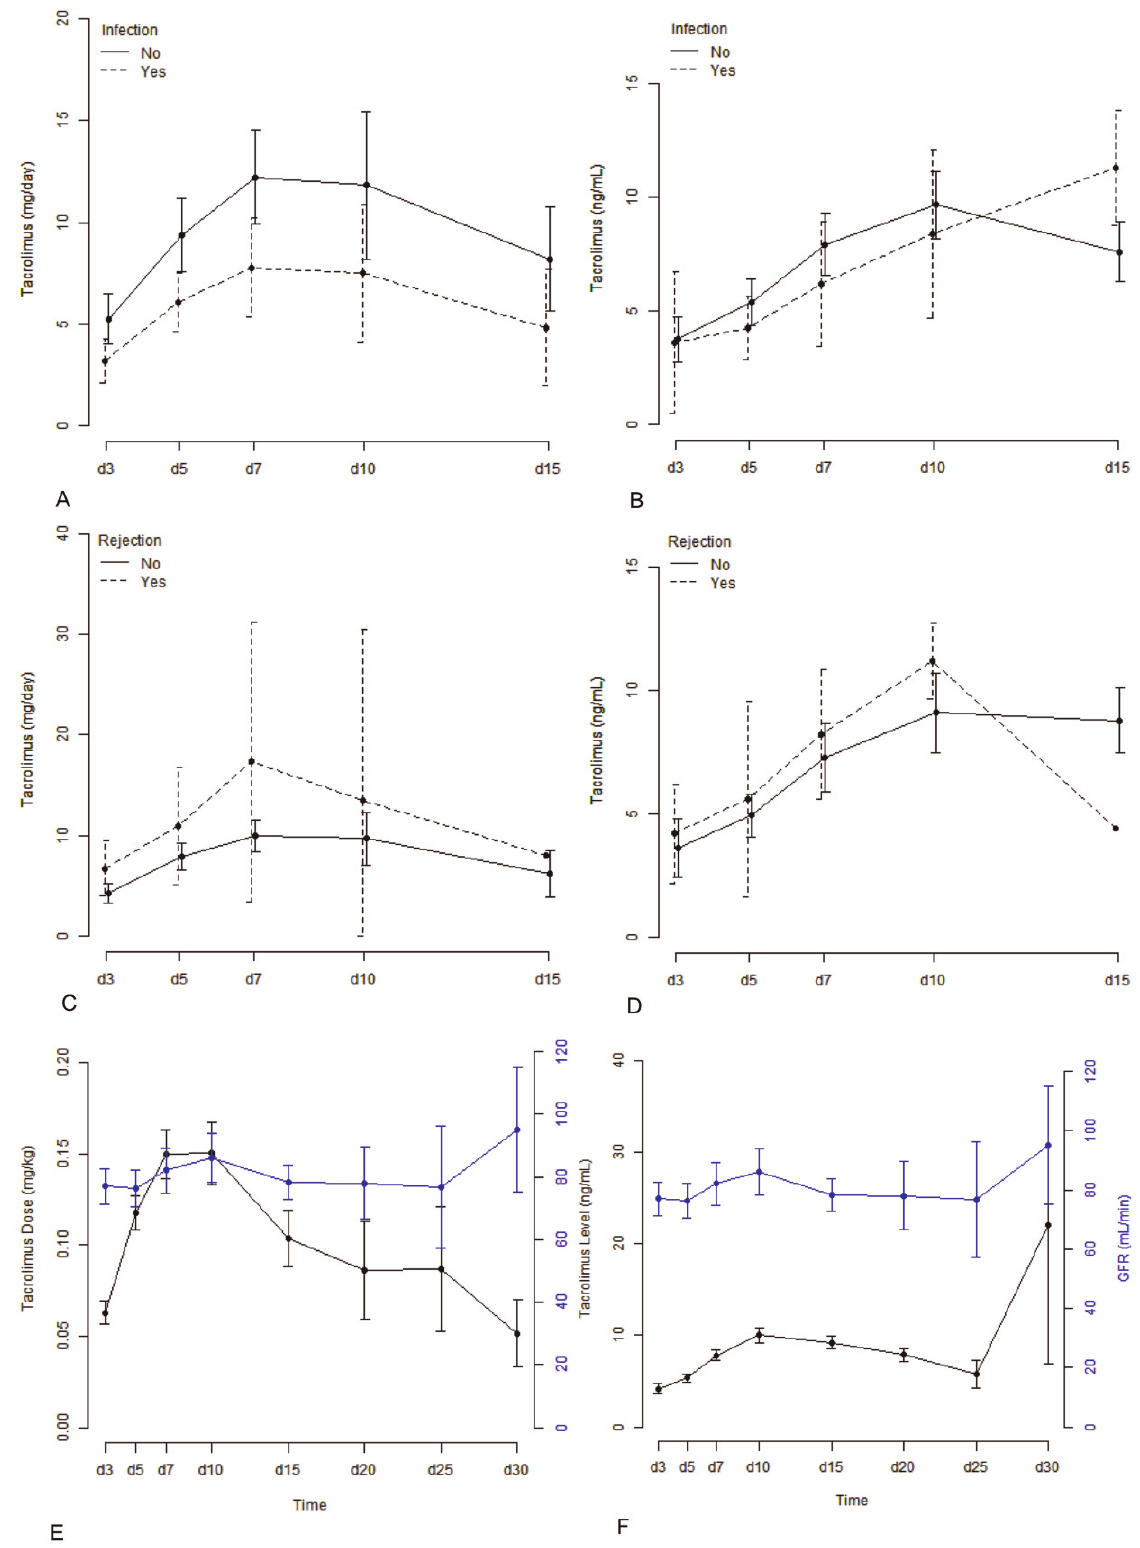
Figure 1 - Comparisons of different parameters after liver transplantation. A - Tacrolimus dose and infection rate over 15 days. B - Serum level of Tacrolimus and infection rate over 15 days. C - Tacrolimus dose and acute cellular rejection rate over 15 days. D - Serum level of Tacrolimus and acute cellular rejection over 15 days. E - Tacrolimus dose and glomerular filtration rate over 30 days. F - Serum level of Tacrolimus and glomerular filtration rate over 30